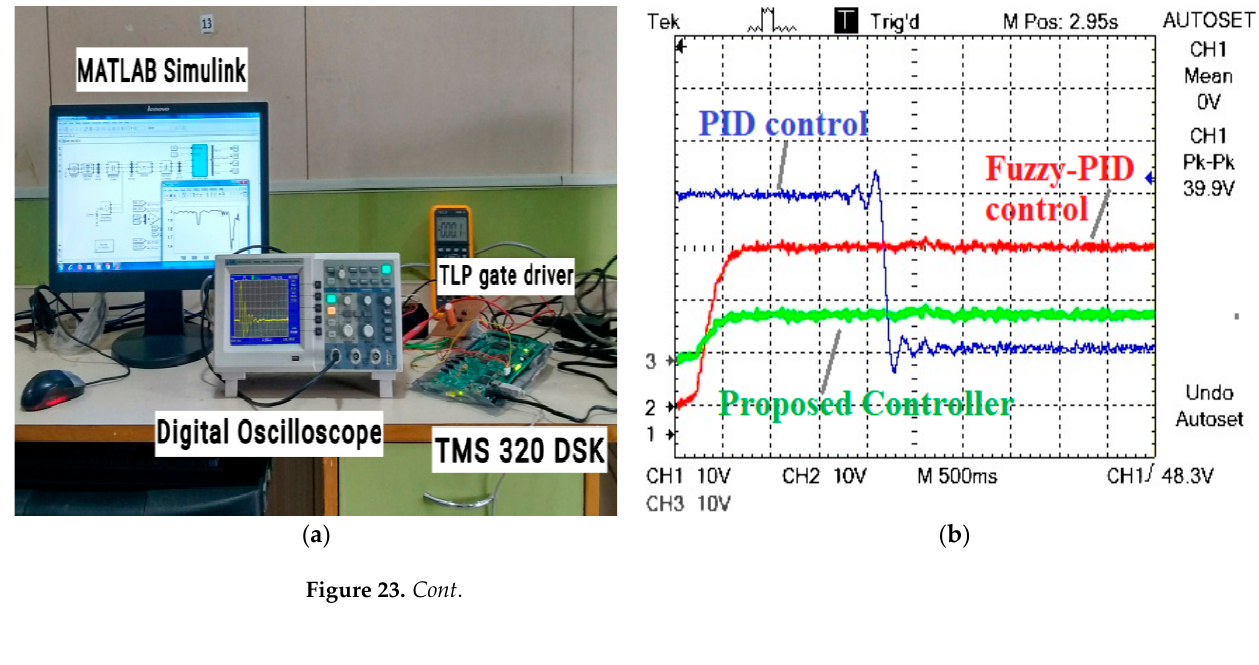
Figure 22. Frequency profile of the complex MG assembly during off-nominal situations with switching interruption and additional noise.